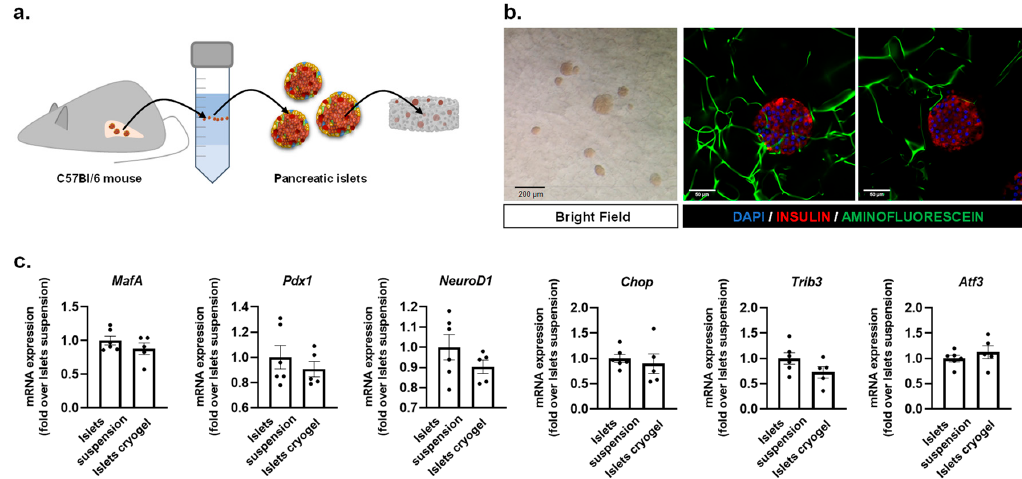
Figure 3. Development and characterization of the CMC islet construct. Gene expression analysis and immunostaining assays of islets were performed 24 h after being seeded within the cryogel. ( a ) Schematic diagram of mouse islet isolation. Islets inside the cryogel are also represented. ( b ) Left: pancreatic islets embedded within a carboxymethyl cellulose (CMC) cryogel under bright field (scale bar: 200 µ m); middle and right: images of islets stained with insulin (red) and DAPI (blue). Cellulose fibers are stained with fluorescein (green). Images show islets at different depths through the cryogel (along the z-axis) (scale bar: 50 µ m). ( c ) Gene expression analysis of MafA , Pdx1 , NeuroD1 , Chop , Trib3 , and Atf3 from islets in suspension and islets housed within the cryogel. Gene expression data were normalized against Tbp1 and are shown relative to islets in suspension. Results are expressed as the mean ± SEM from three independent experiments. A t -test was applied to compare the data set, evidencing no statistical differences between islets in suspension and islets in the cryogel.